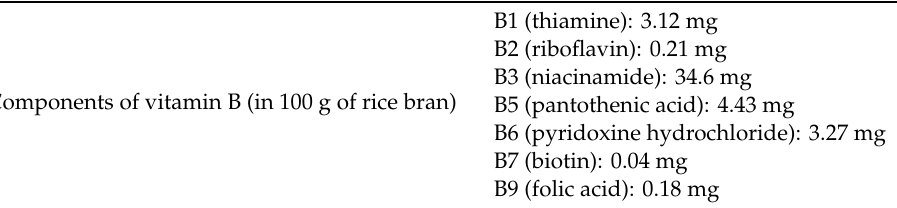
Table A3. Ingredient information (www.mext.go.jp/a_menu/syokuhinseibun).